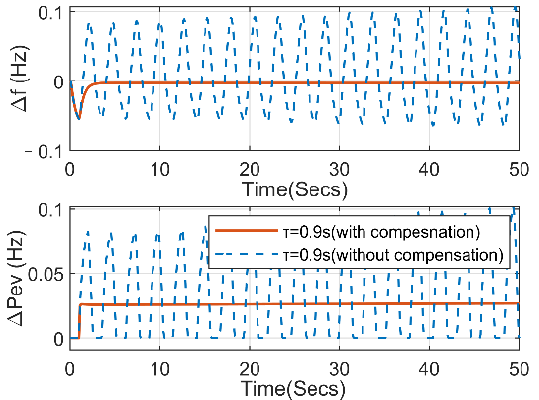
Figure 9. τ = 0.9 s system dynamic response with or without predictive compensation.